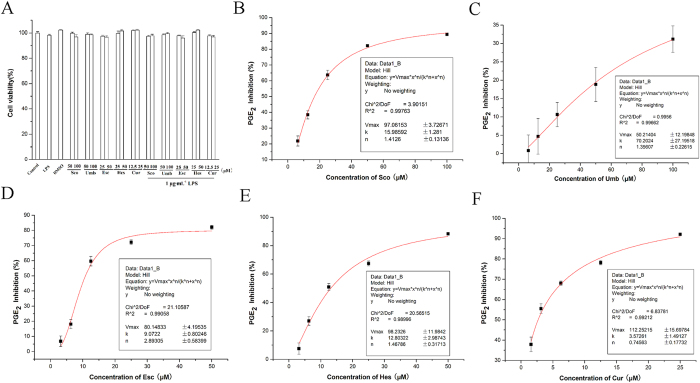
Concentration-effect relationship of compounds from BE-IS on LPS-induced the production of PGE2.(A) Cytotoxic effects of compounds from BE-IS. Raw264.7 cells were treated with Sco, Umb, Esc, Hes and Cur individully or followed by 1 μg·mL−1 LPS for 24 h. Cells were then subjected to MTT assay as described in the Methods. (B–F) Concentration-effect relationship of Sco (B), Umb (C), Esc (D), Hes (E) and Cur (F) on LPS-induced the production of PGE2. Drugs were dissolved in DMSO and diluted in DMEM to a final value of DMSO <0.1%. All values are presented as the mean ± S.E. and are the result of three independent experiments.